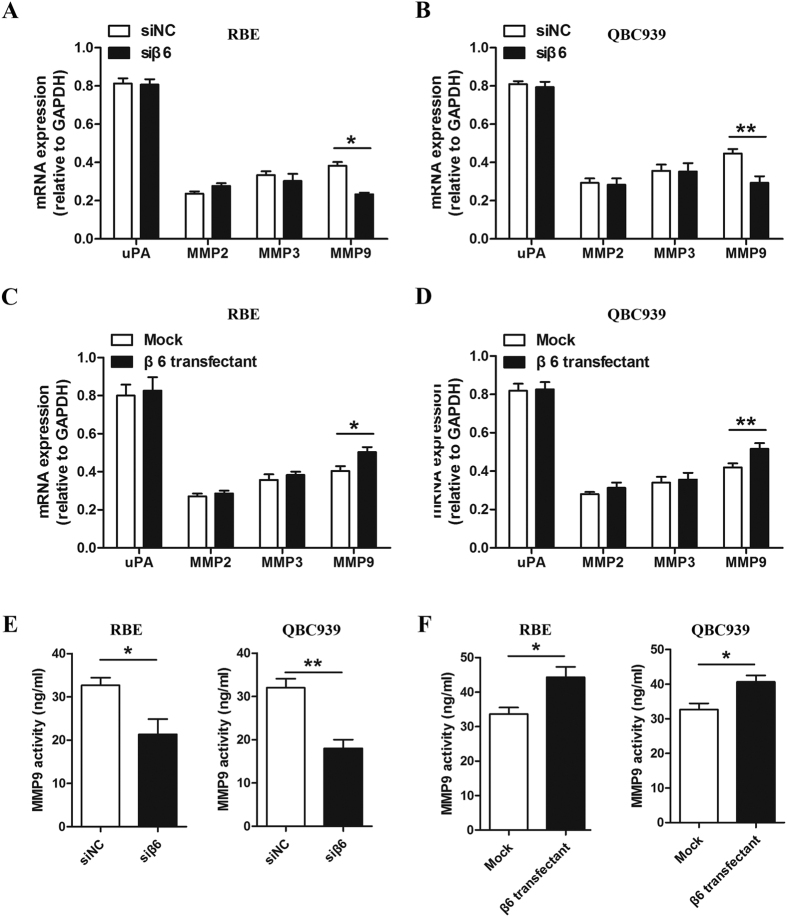
Integrin β6 increased MMP9 expression at both the mRNA and protein levels.(A,B) MMP9 mRNA was significantly decreased in RBE cells (A) and QBC939 cells (B) after transfection with β6 siRNA, while the expression of uPA, MMP2 and MMP3 showed no significant changes. (C,D) MMP9 mRNA was significantly increased in RBE cells (C) and QBC939 cells (D) after β6 overexpression, while the expression of uPA, MMP2 and MMP3 showed no significant changes. (E) The protein level of MMP9 was detected by ELISA in RBE and QBC939 cells transfected with β6 siRNA. (F) The protein level of MMP9 was detected by ELISA in RBE and QBC939 cells after β6 overexpression. Data represent the mean ± SD from three independent experiments. *P < 0.05; **P < 0.01.